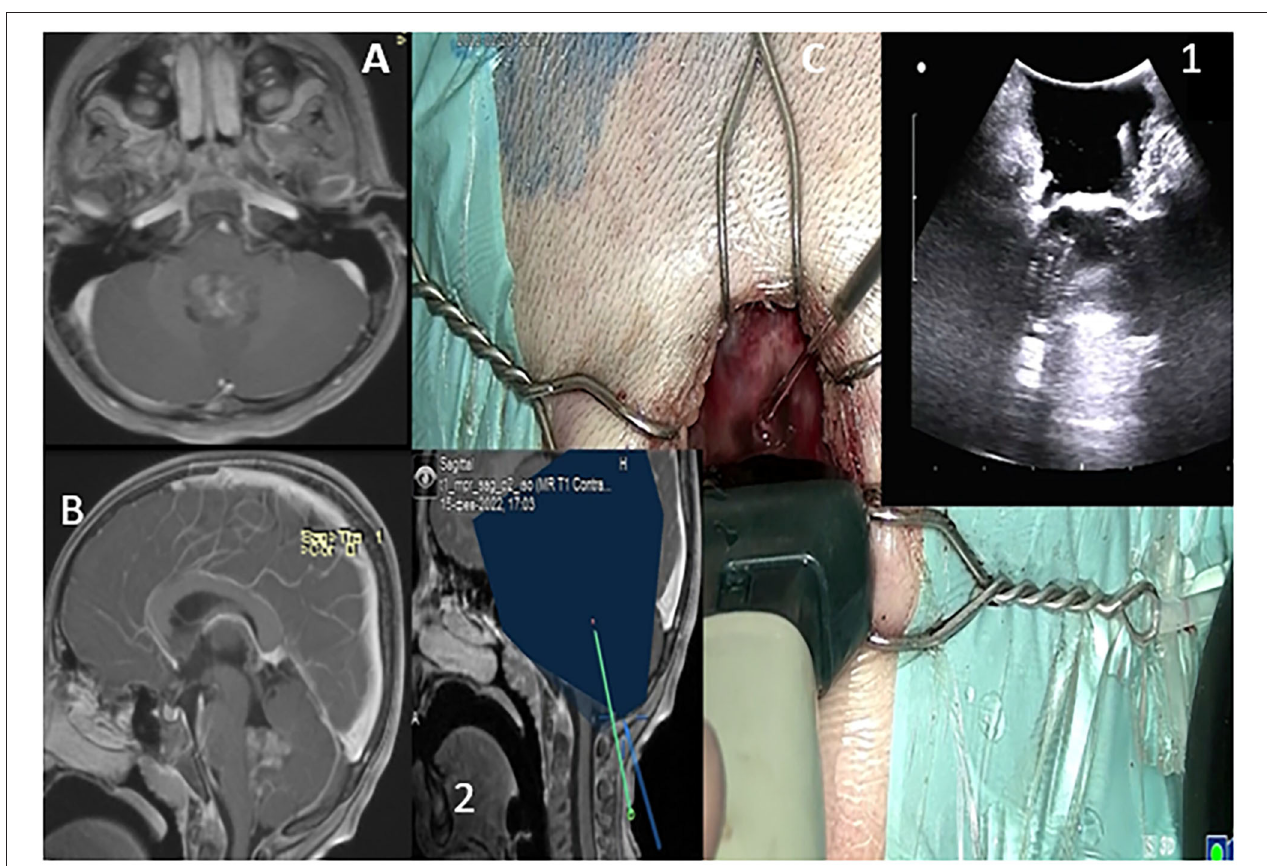
FIGURE 6 | T1WI in sagittal and axial sections depicting 4th ventricular lesion (A,B) . Probe is placed over the dura to acquire standard B-mode imaging scans via a sub occipital approach. The lesion is depicted as hyperechoic incaved between cerebellar tonsils (C,1) . The trajectory to the lesion is also depicted (C,2)